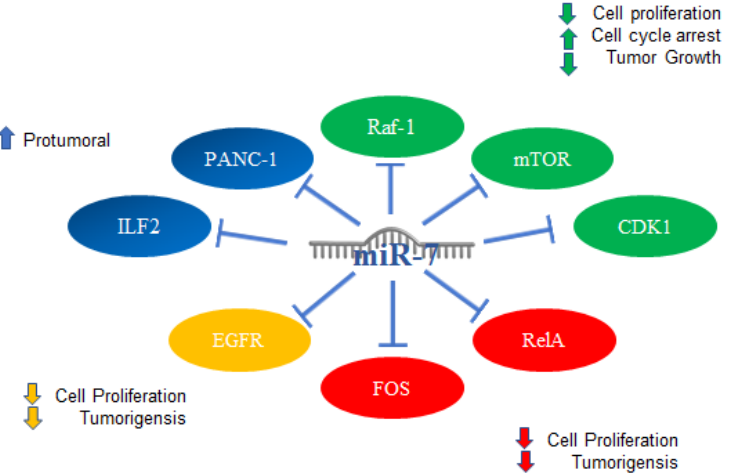
Figure 9. miR-7 in other types of cancer. Schematic representation of protein interactions with miR-7 and its biological consequences in several type of cancer, (blue) pancreatic, (green) adrenocortical cancer, (red) gastric, and (yellow) ovarian.